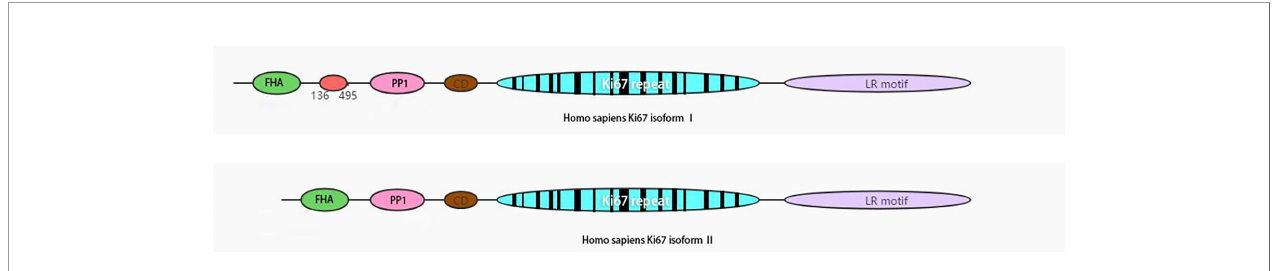
FIGURE 1 | Schematic view of human Ki67 protein structure. The isoform II lacks amino acid 136-495. FHA, forkhead-associated domain; PP1, PP1-binding domain; CD, conserved domain; LR, leucine-arginine-rich